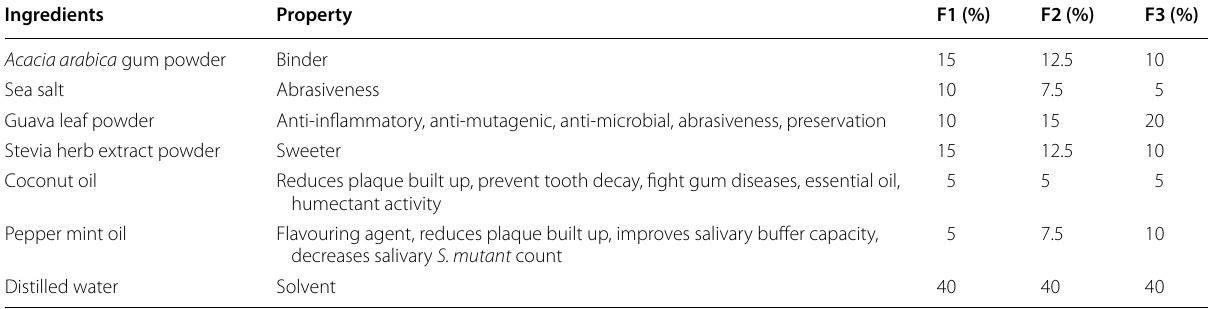
Table 1 Composition ratio of ingredients used in different tooth paste formulations